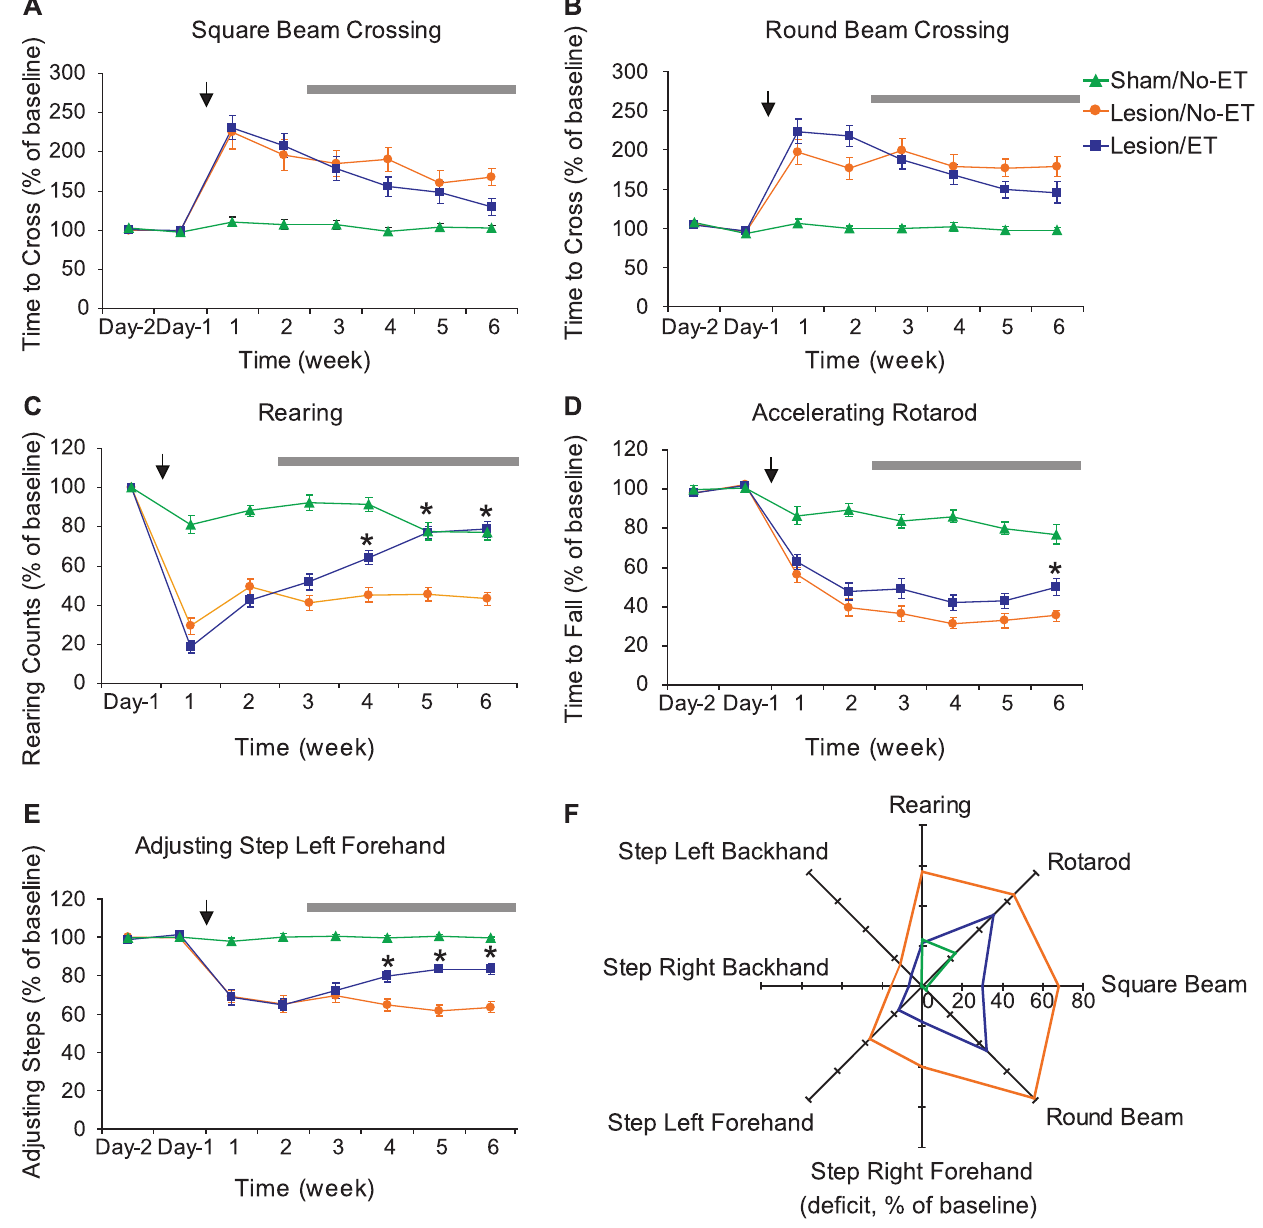
Figure 4. Striatal lesioning-induced motor deficits and exercise training (ET)-induced recovery in motor function. (A–E) Time course of motor tests results. Main effect of lesion was analyzed with repeated measure two-way ANOVA comparing Sham/No-ET ( n =19) and Lesion/No-ET ( n =19) groups over the 6 weeks period after lesioning (time of lesioning was denoted with the arrows). Lesion-induced motor deficits were significant in all motor tests, and post hoc tests showed significant lesion-induced deficits at all time points. Main effect of ET was analyzed with repeated measure two-way ANOVA comparing Lesion/No-ET and Lesion/ET ( n =23) groups over the 4 weeks ET period (denoted by the horizontal bars). ET-induced improvements were significant for the rearing, accelerating rotarod, and adjusting step tests, with nonsignificant trends shown in the beam crossing tests. *: signifcant effect of ET by post hoc tests ( P , 0.05). Only data for the left forehand adjusting step test were shown, which were representative of all four adjusting step tests. (F) The radar graph depicts the deficit (as a % of prelesion baseline) for each motor test at the 6 week time point. Four-week ET induced statistically significant improvement in all motor tests ( P , 0.05, Student’s t-test) except the round beam test ( P